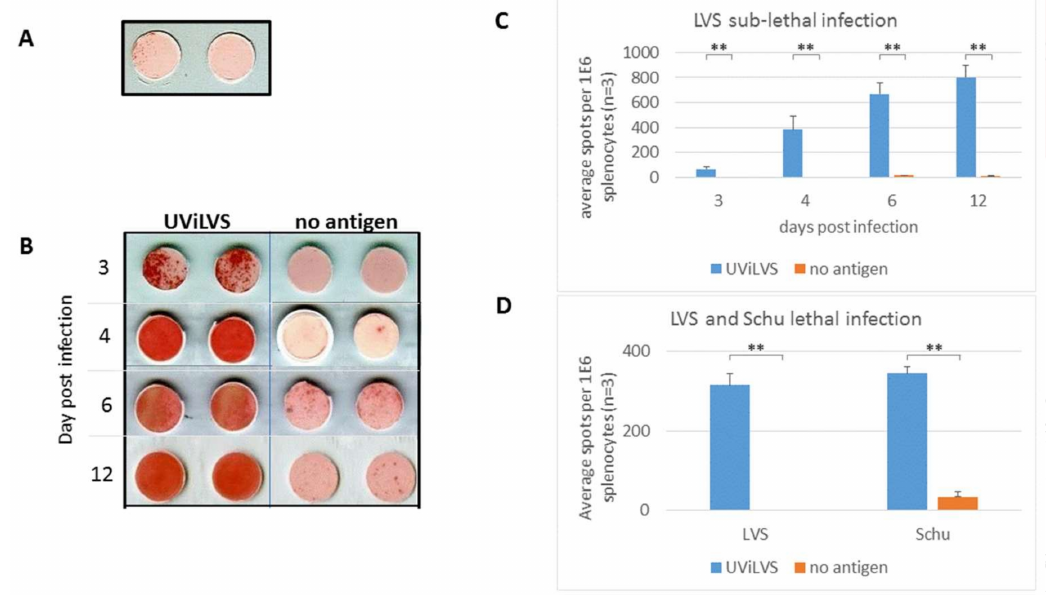
Figure 1. IFN γ ELISPOT response in the spleen following intranasal infection with F. tularensis . Mice were infected with a sub-lethal dose (10 2 cfu, 0.1 LD 50 ) of LVS strain, or with a lethal dose of 10 5 cfu LVS or 10 2 Schu strain (100 LD 50 ). Animals were sacrificed and splenocytes were stimulated in situ in an ELISPOT assay with UV-inactivated LVS (UViLVS, 5E7 cfu equivalent / mL) or left untreated (no antigen). Images of 10 6 cells / well of splenocytes from naïve ( A ) or sub-lethal LVS-infected mice (day 3 post infection) ( B ) are presented. ( C ) Quantification of IFN γ spots represent groups of 3 mice, collected in the indicated time-points following sub-lethal LVS infection, and individually assayed as described above. ( D ) Three mice were collected 3 days following lethal intranasal infection with LVS (10 5 cfu) or Schu strain (10 2 cfu), and assayed as described above. Data are representative of three (LVS infections) and two (SchuS4 infections) independently performed experiments. ** p <